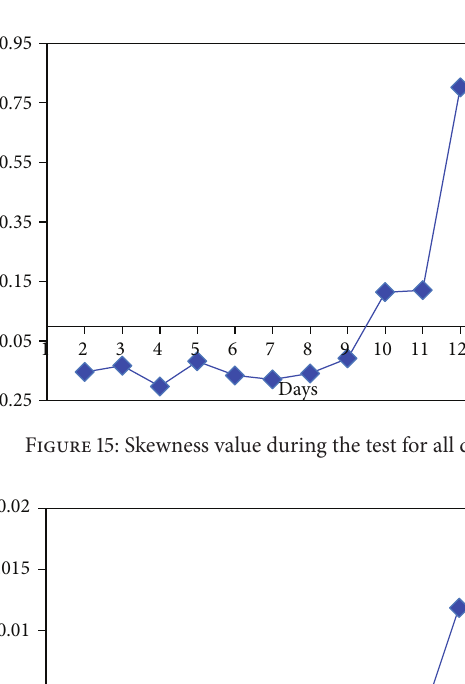
Figure 11: RMS (m/s 2 ) value during the test for all days.